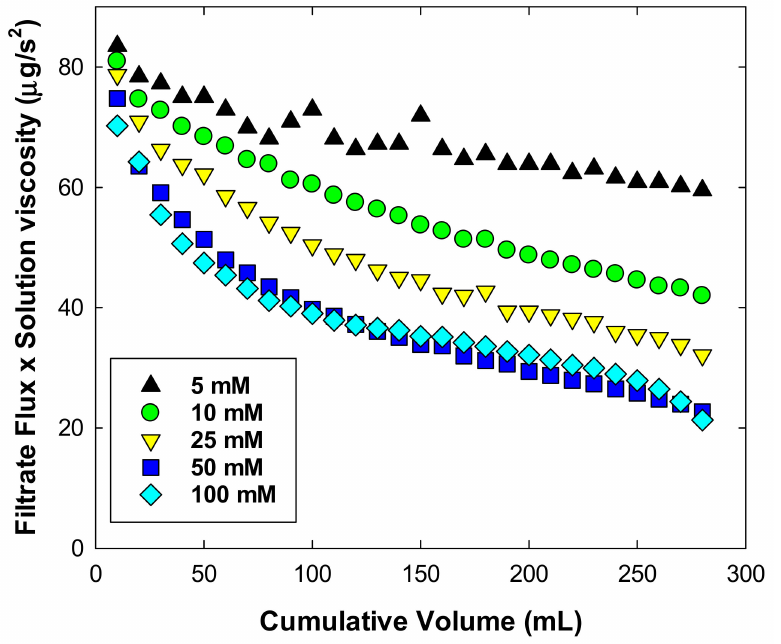
Figure 6. Normalized flux as a function of the filtrated volume during ultrafiltration using a normal flow filtration system at an applied pressure of 100 kPa, with a stirring speed of 800